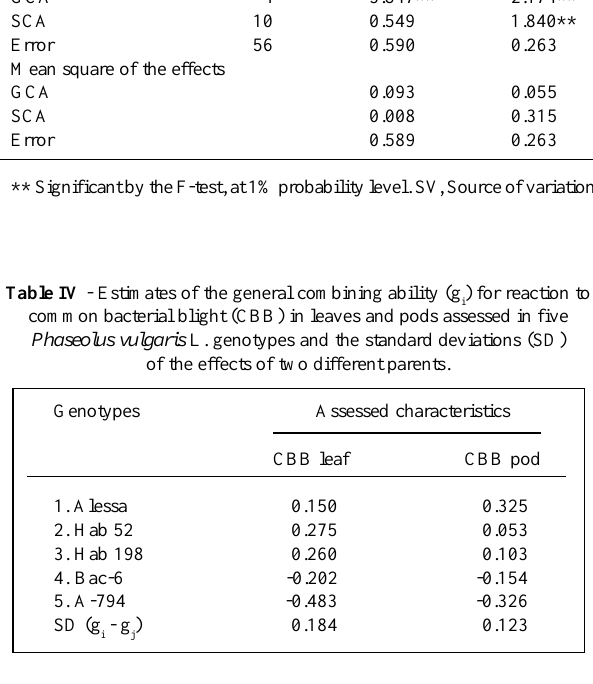
and s ) effects ii ij